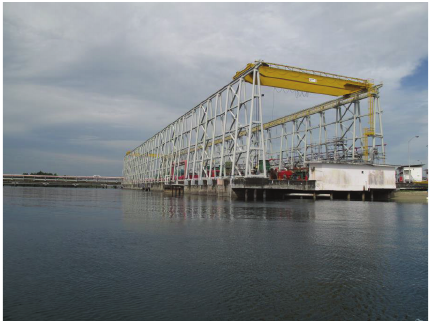
Figure 1: Cracking of concrete plate (slab) of CWICS. Figure 2: Front view of